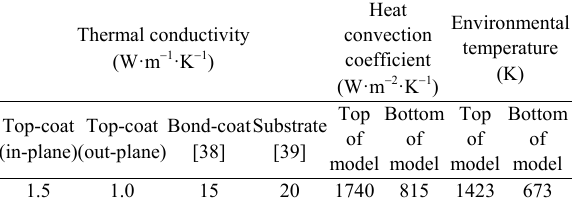
Table 2 Thermal parameters used in simulation Thermal conductivity